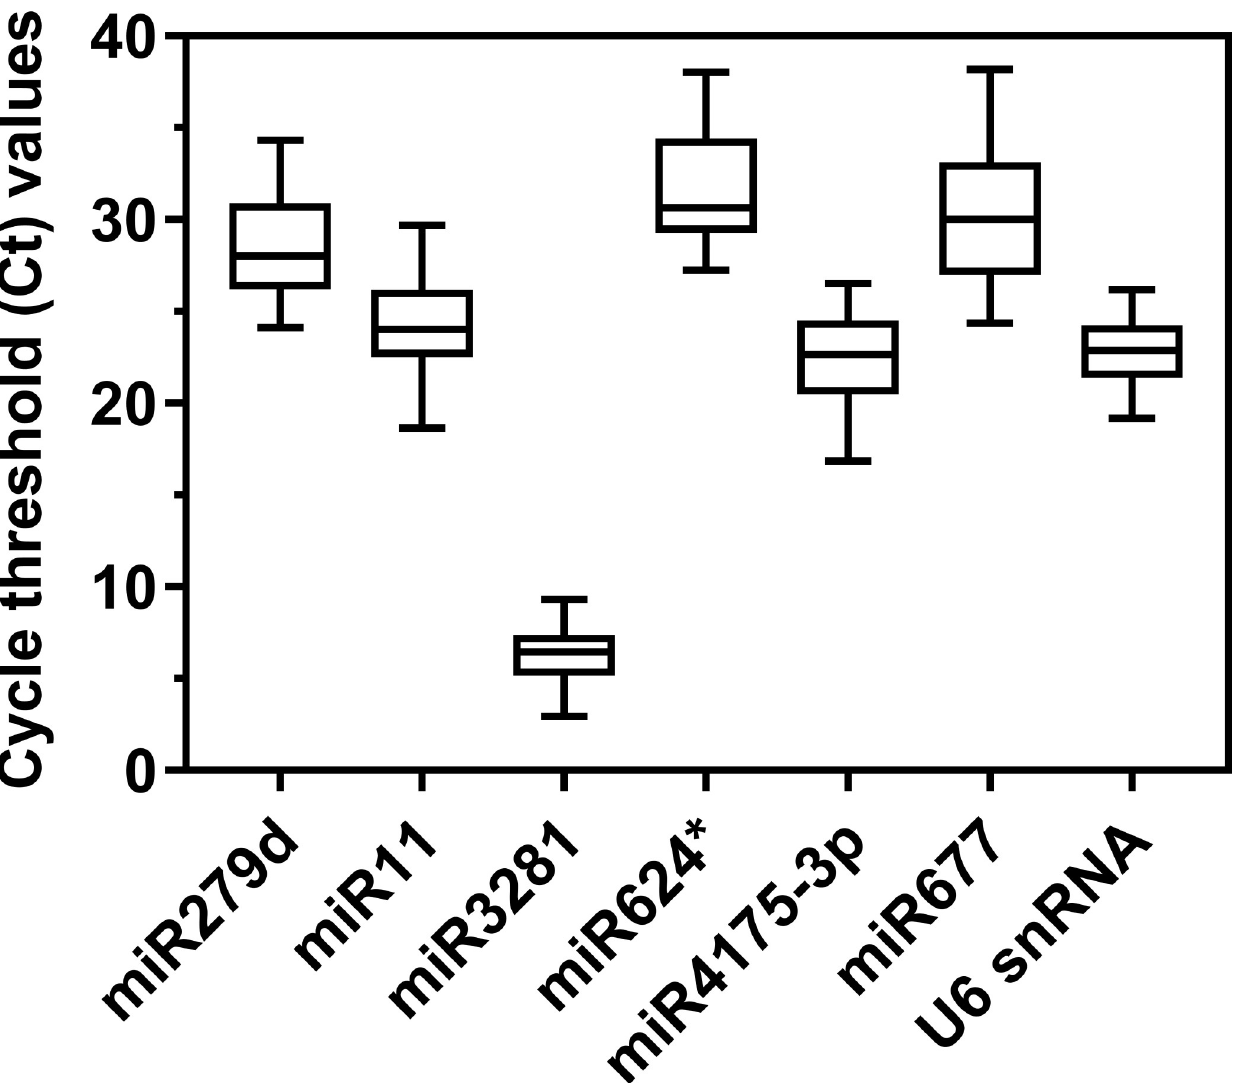
Fig 1. Cycle threshold (Ct) values of candidate reference genes. The Ct values of the candidate reference genes were measured in the samples from G88 and GC strains as described in the Materials and Methods.